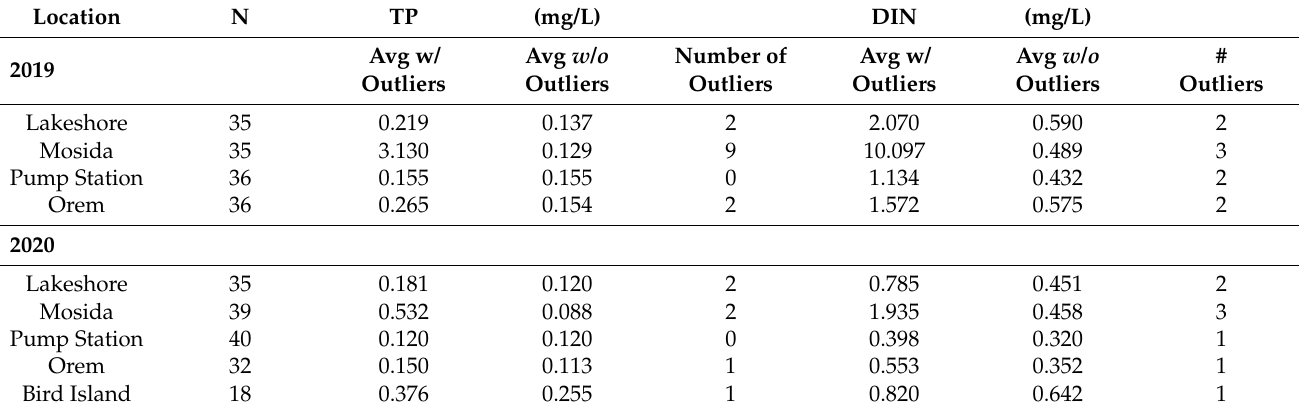
Table 2. A comparison of all the data with and without outliers removed from 2019 and 2020. This includes four and five stations for 2019 and 2020,